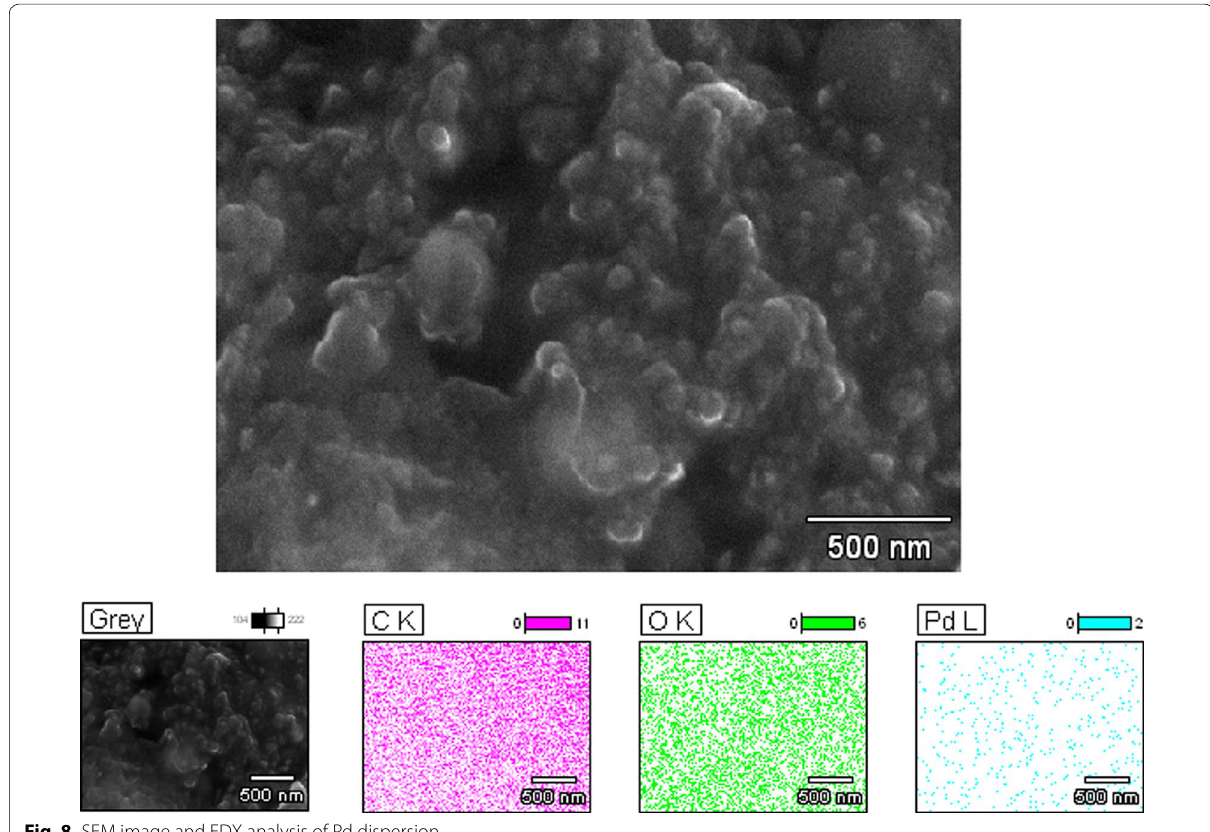
Fig. 8 SEM image and EDX analysis of Pd